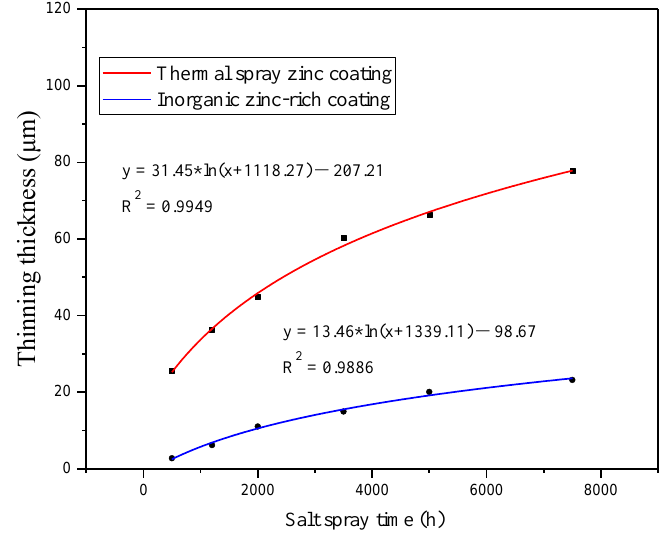
Figure 17. Fit curves of the salt-spray time-varying corrosion thickness loss per unit area.